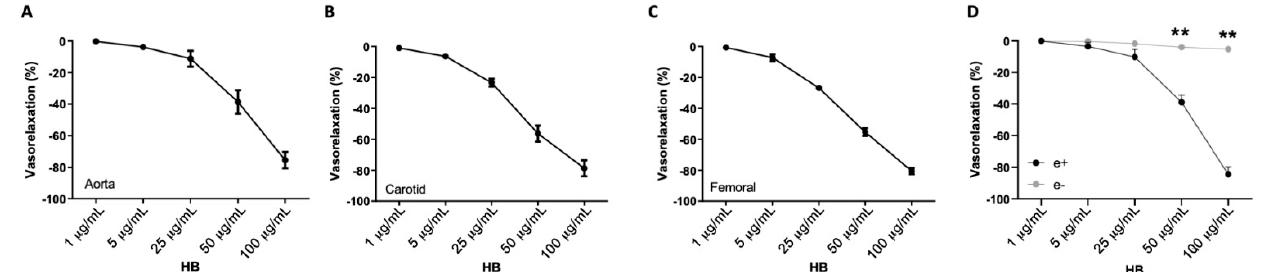
Figure 1. ( A – D ) Vascular response of phenylephrine-precontracted mice vessels to increasing doses of HB (1–100 µg/mL) on ( A ) aorta ( N = 5), ( B ) carotid ( N = 5), ( C ) femoral ( N = 5), or ( D ) vascular response of phenylephrine-precontracted mice mesenteric arteries to increasing doses of HB in vessels with endothelium (e+) and without endothelium (e − ) ( N = 5). ** p < 0.01.